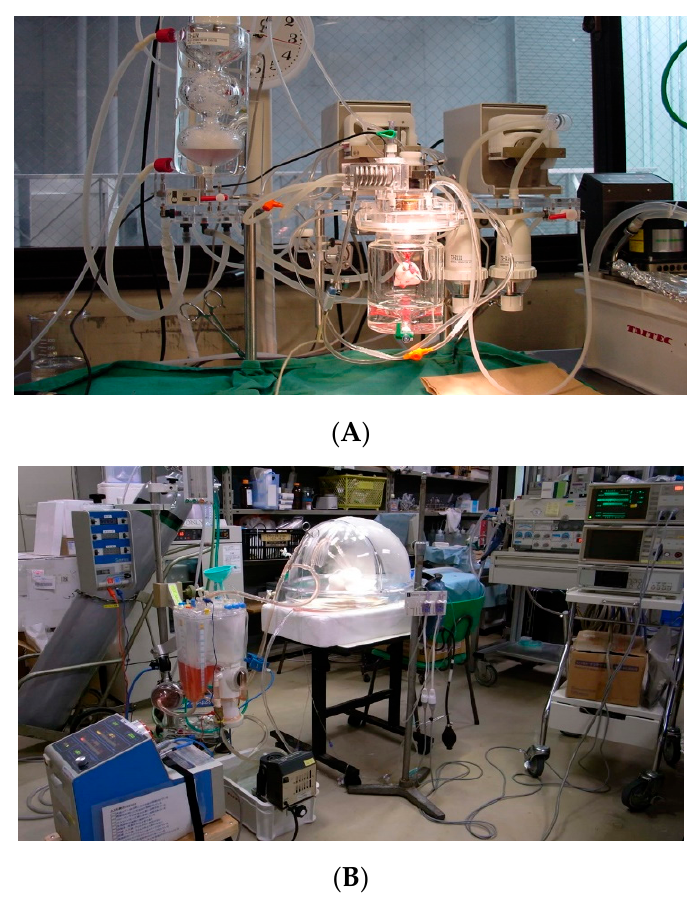
Figure 2. ( A ) Rodent ex vivo lung perfusion (EVLP) model. ( B ) Swine EVLP model.